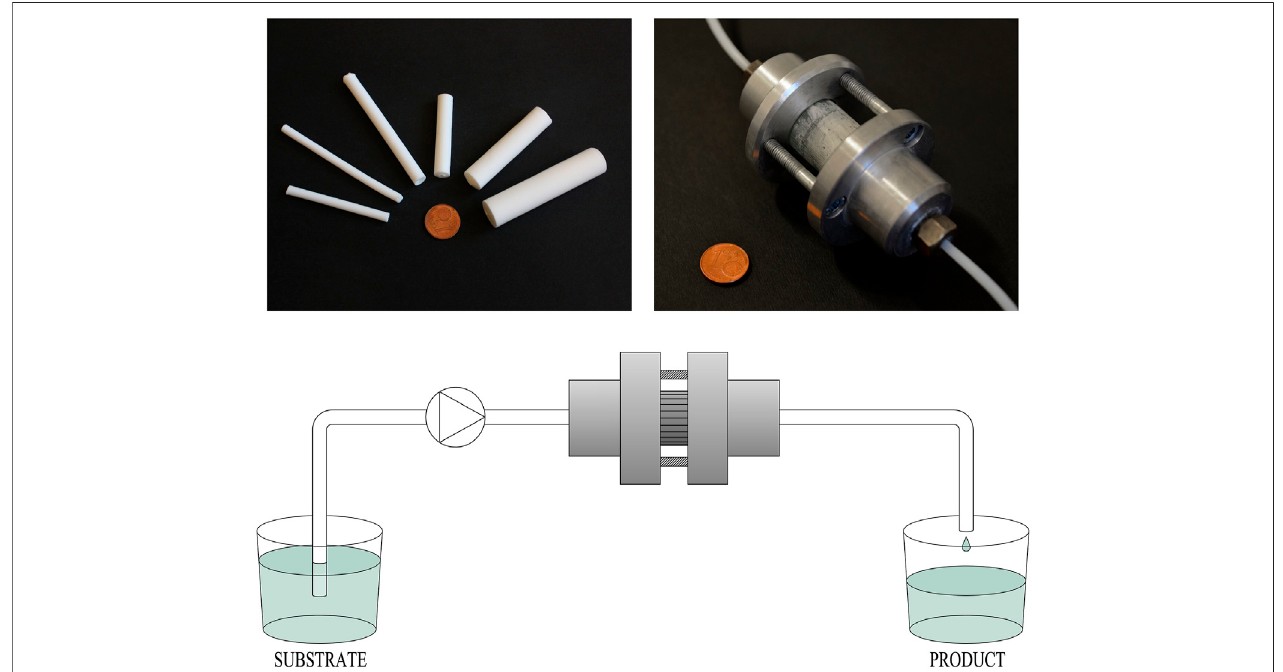
FIGURE 1 | Silica monoliths with the hierarchical pore structure applied as a core of the microreactor for continuous- fl ow processes.